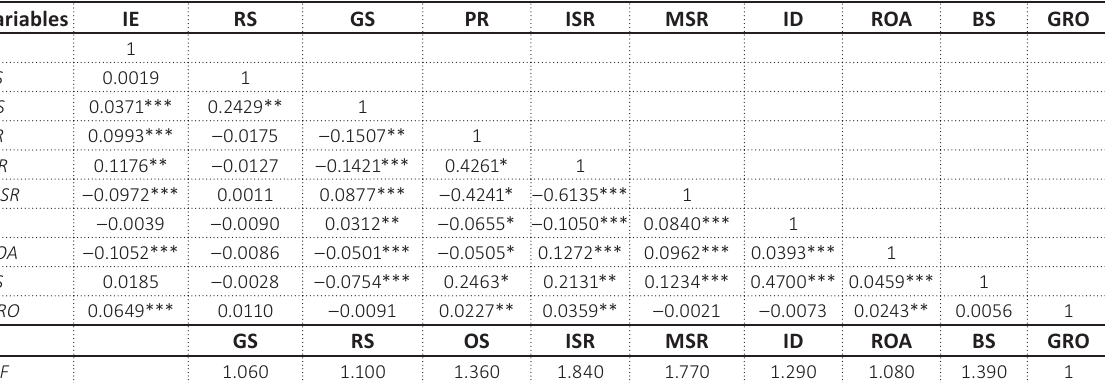
Table 2. Correlations and